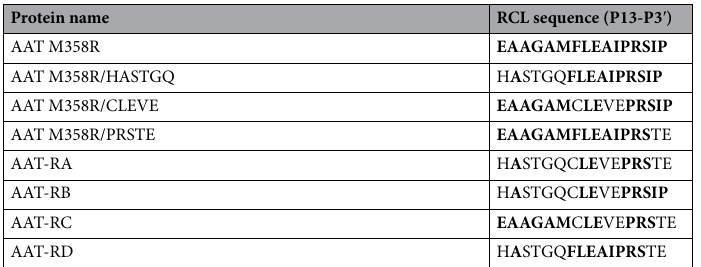
Table 2. RCL Sequences of AAT M358R and variants examined in this study. Primary amino acid sequences of various AAT M358R derivatives between P13 (E346) and P3 ′ (P361) are shown. Bold indicates AAT M358R sequence; regular indicates mutated residues.